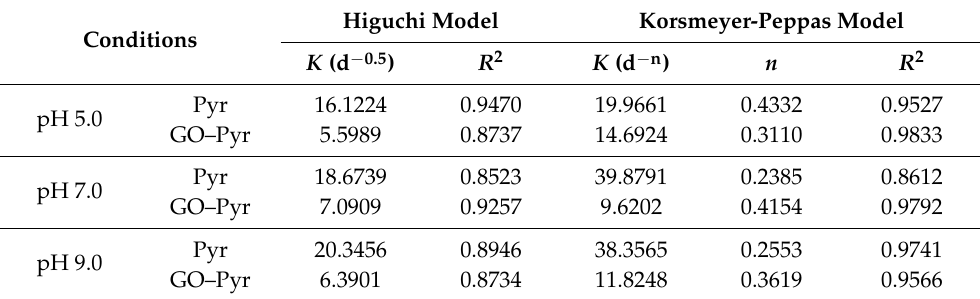
Table 2. Kinetic parameters of Pyr release from GO–Pyr nanocomposite at pH 5.0, 6.0 and 7.0.